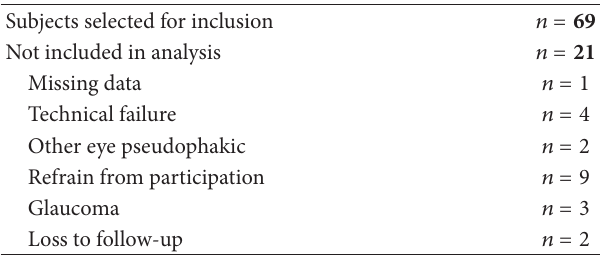
Table 1: The number of subjects in the study and the reasons for exclusion of subjects.